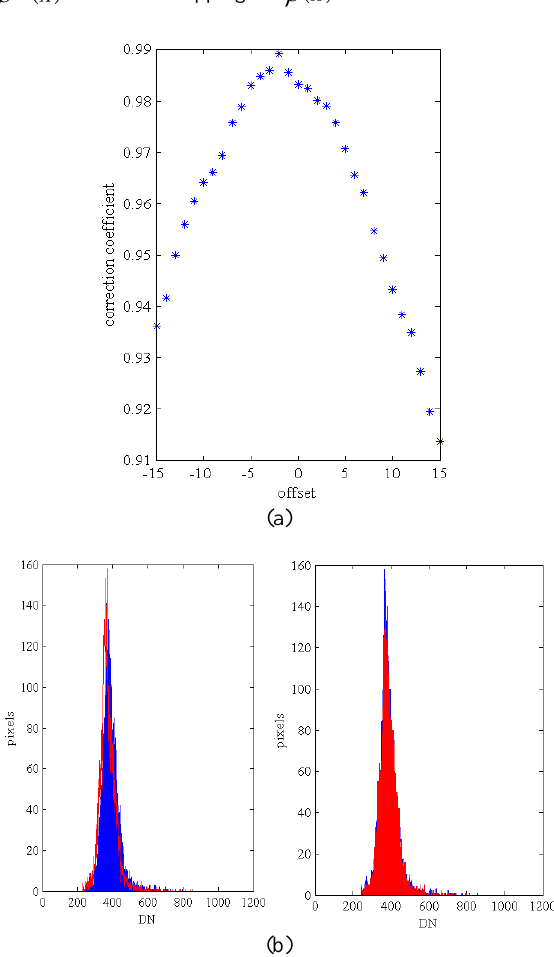
Figure 2 (a)result of correlation search,(b) comparision of histogram before(left) and after refine correction(right) The histogrammic contrast before and after refine correlation is shown in Figure 2. The grey level offset based on the correlation search is -2(Figure 2(a)). The two histograms are nearly coincident after refine correction(Figure 2(b)).